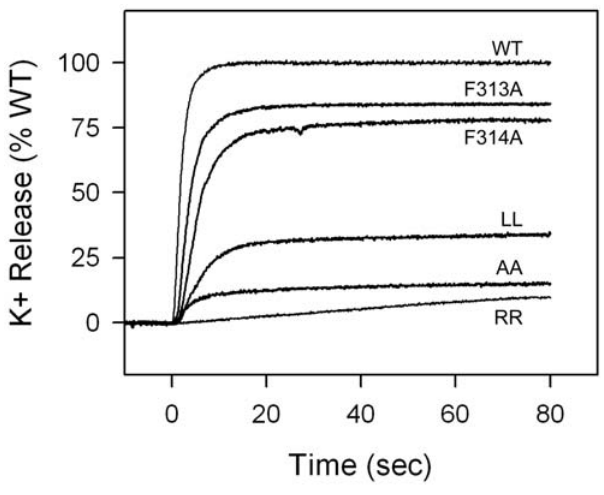
Figure 2. Effects of F313 and F314 mutations on PA permea- bilization of membranes to K + . For clarity, only selected mutants are shown. The double Trp (WW) and double Tyr (YY) replacements had approximately the same kinetics of K + release as the WT (FF). The kinetics of release by the double Leu (LL), double Ala (AA), and double Arg (RR), as well as the F313A and F314A mutants are also shown. The double His (HH), double Asp (DD), and the buffer control results were indistinguishable from those of RR. doi:10.1371/journal.pone.0006280.g002 type (data not shown). Also, the probability of residing in the open state did not vary from the wild-type pore.